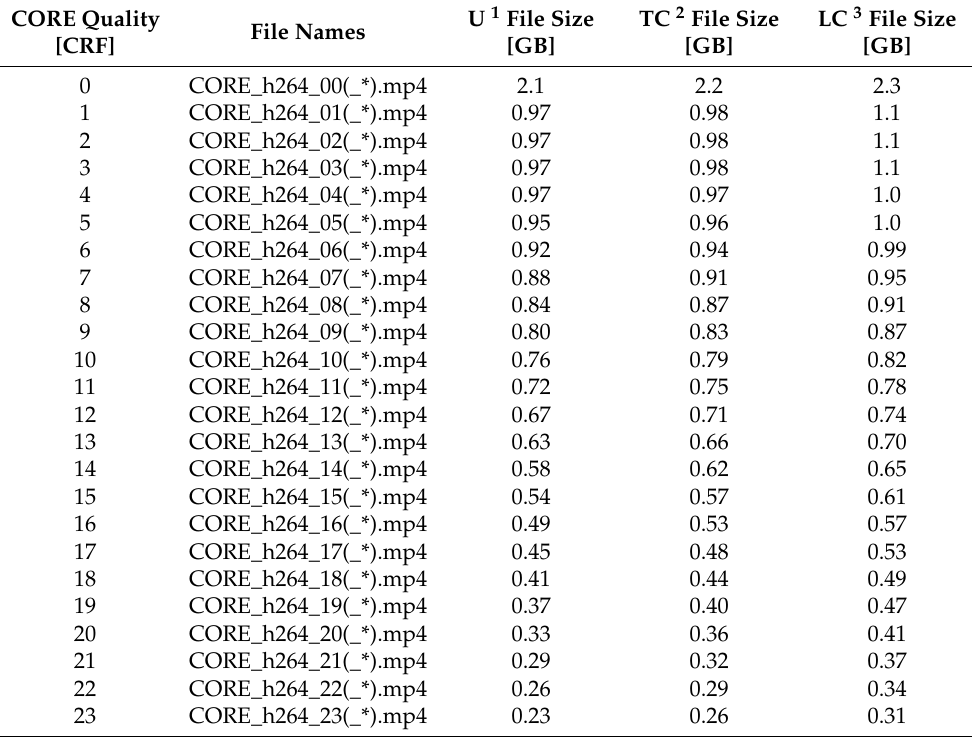
Table A1 reviews the file sizes obtained for the different CORE files with a specific CRF encoding, as uniformly listed in the cloud at https://envicloud.wsl.ch/#/?prefix= Table A1. Variation of the file size with increasing